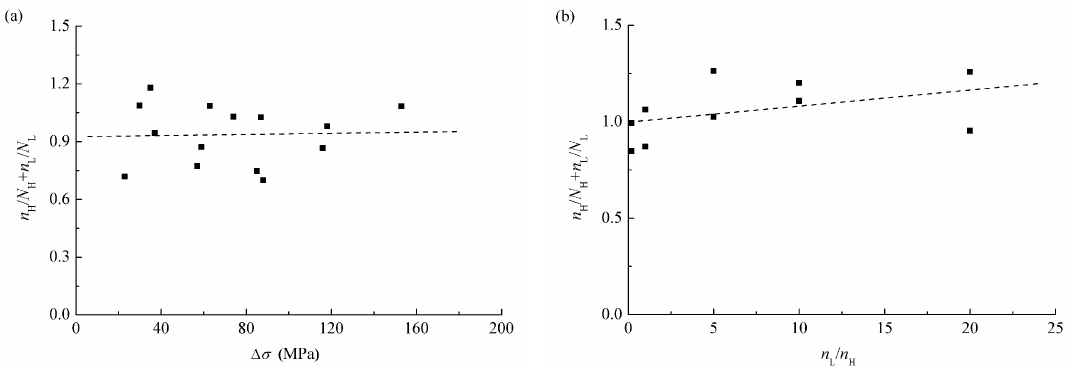
Figure 10. Correlations between Δ σ and n H / N H + n L / N L in the cases of ( a ) n L / n H = 1 and ( b ) Δ σ = 59 MPa.